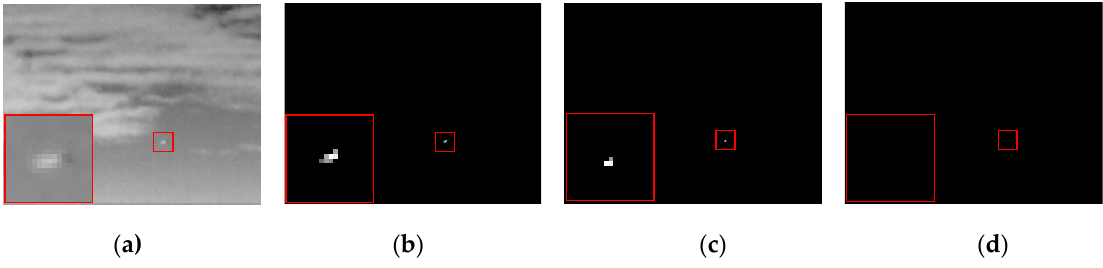
Figure 5. The phenomenon of target over-contraction with the increasing of h. ( a ) Original image; ( b )–( d ) The separated target image when h = 1,3,5, respectively.